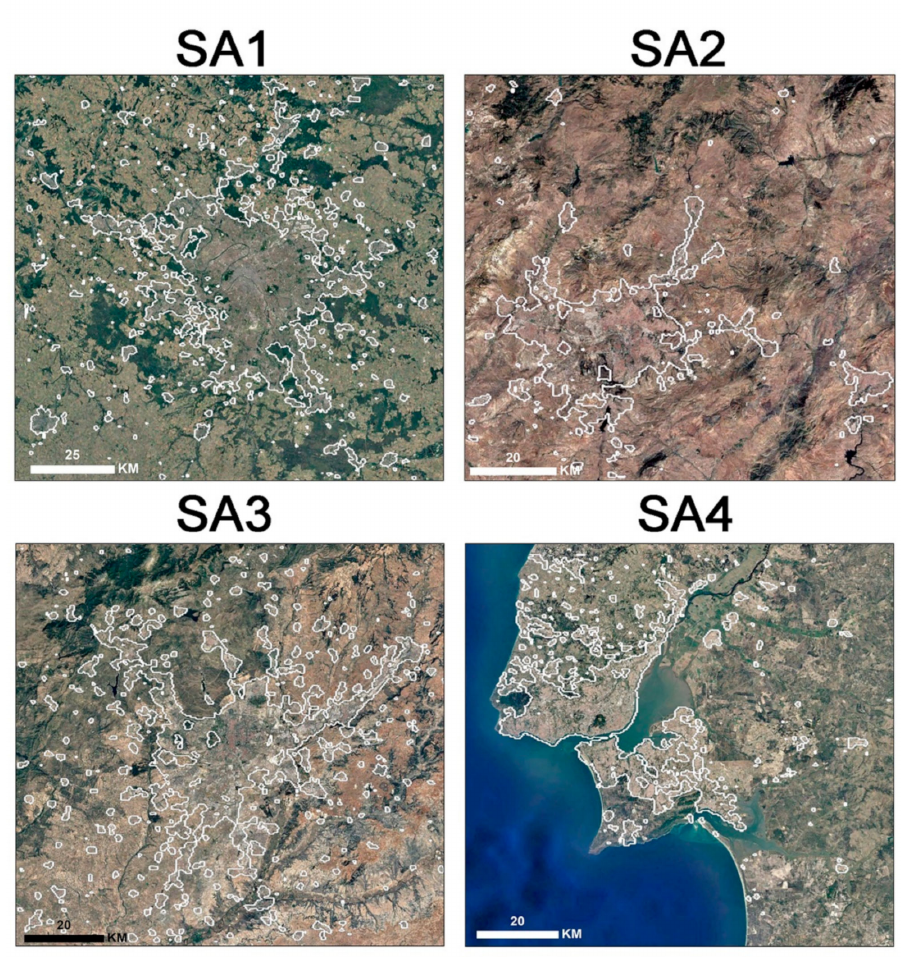
Figure 10. Distribution maps of built-up target areas. The white polygonal areas represent the built-up target area selected using the VIIRS nighttime lights